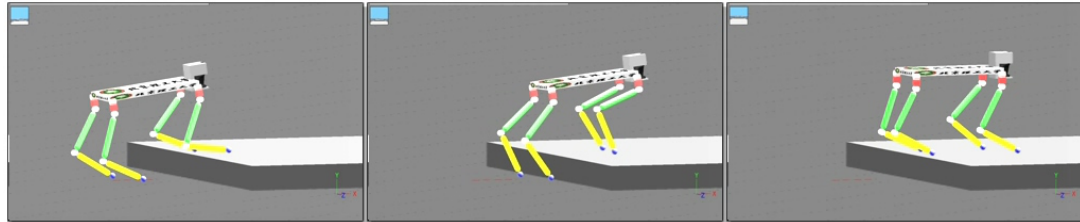
Figure 15. Simulation of quadruped robot walking on high platform with 0.2 m.